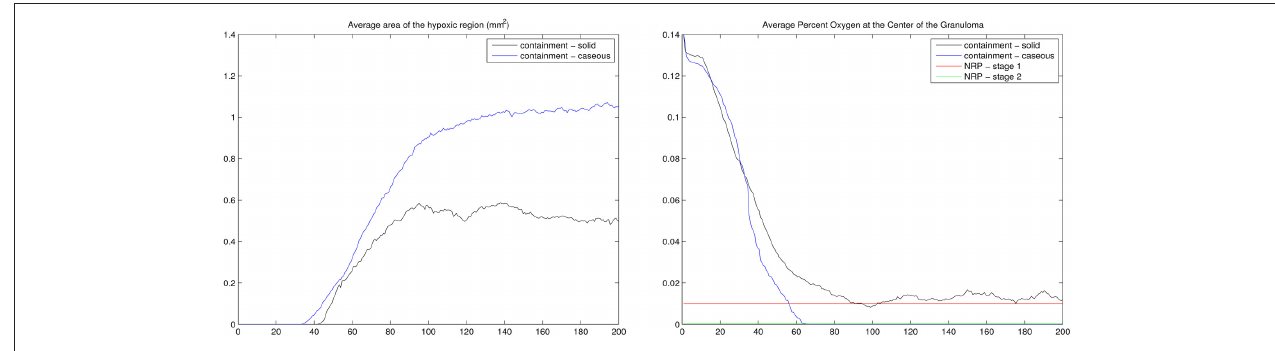
FIGURE 7 | For the containment granuloma: average area of the hypoxic region in mm 2 (Left) and the average percent of oxygen in tissue at the center of the granuloma (Right). Containment granulomas were divided into two groups: caseous and solid. NRP stages (Wayne and Hayes, 1996) are notated (right). Results based on 20 simulation